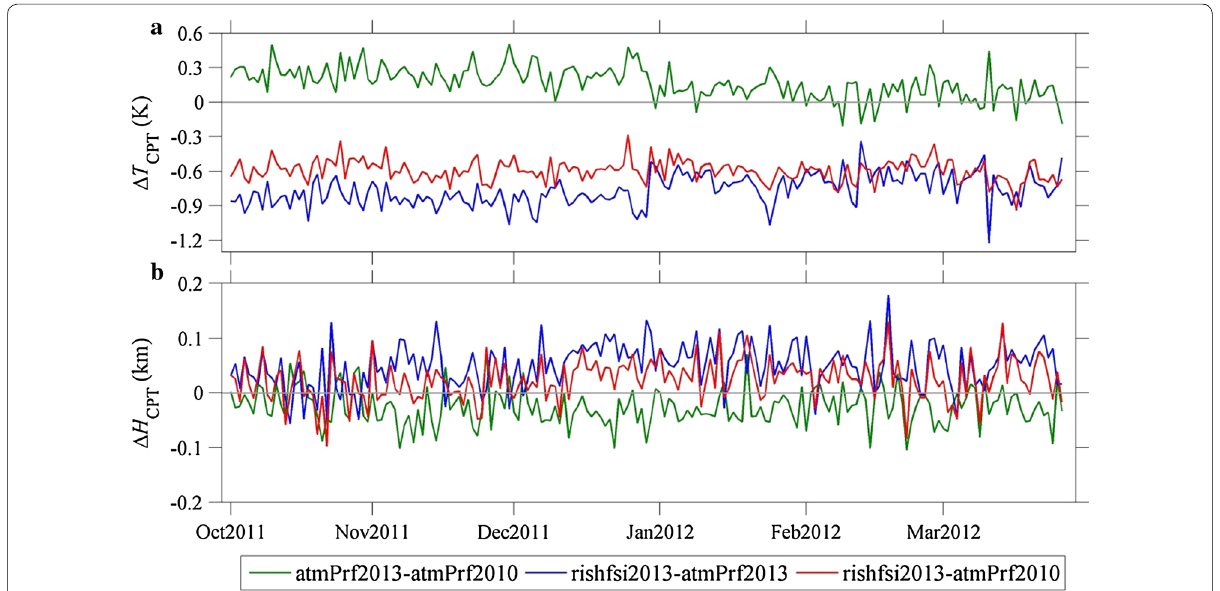
Fig. 5 a Daily mean difference of the CPT temperature (∆ T CPT ) and b the difference of the CPT altitude (∆ H CPT ) among the three COSMIC GPS-RO datasets. Tick marks on the horizontal axis indicate the first day of the corresponding month